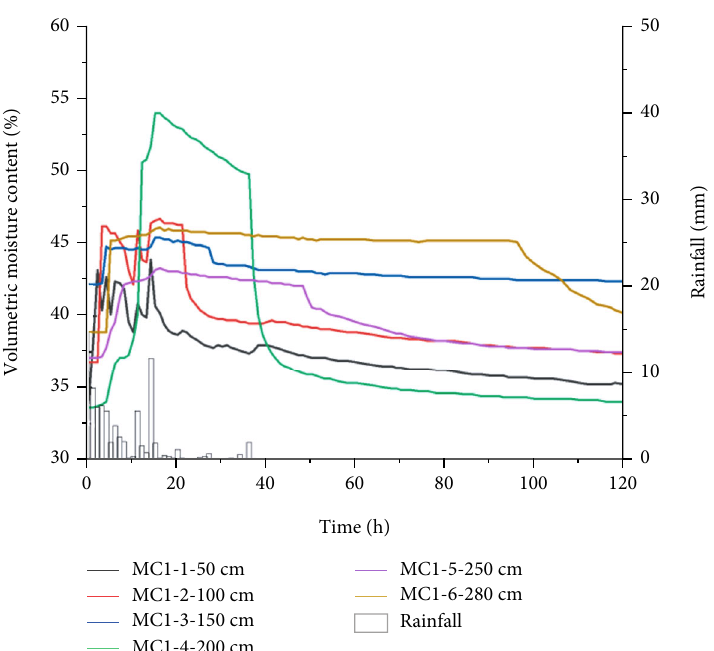
Figure 7: Relationship curve between rainfall and moisture contents at di ff erent depths of point